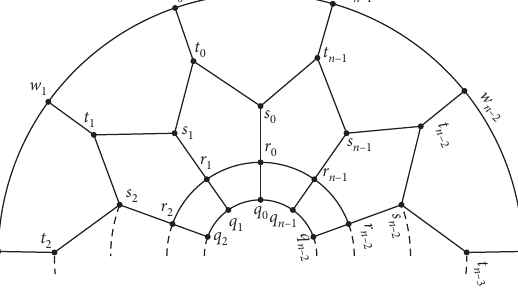
Figure 2: : Convex polytope U